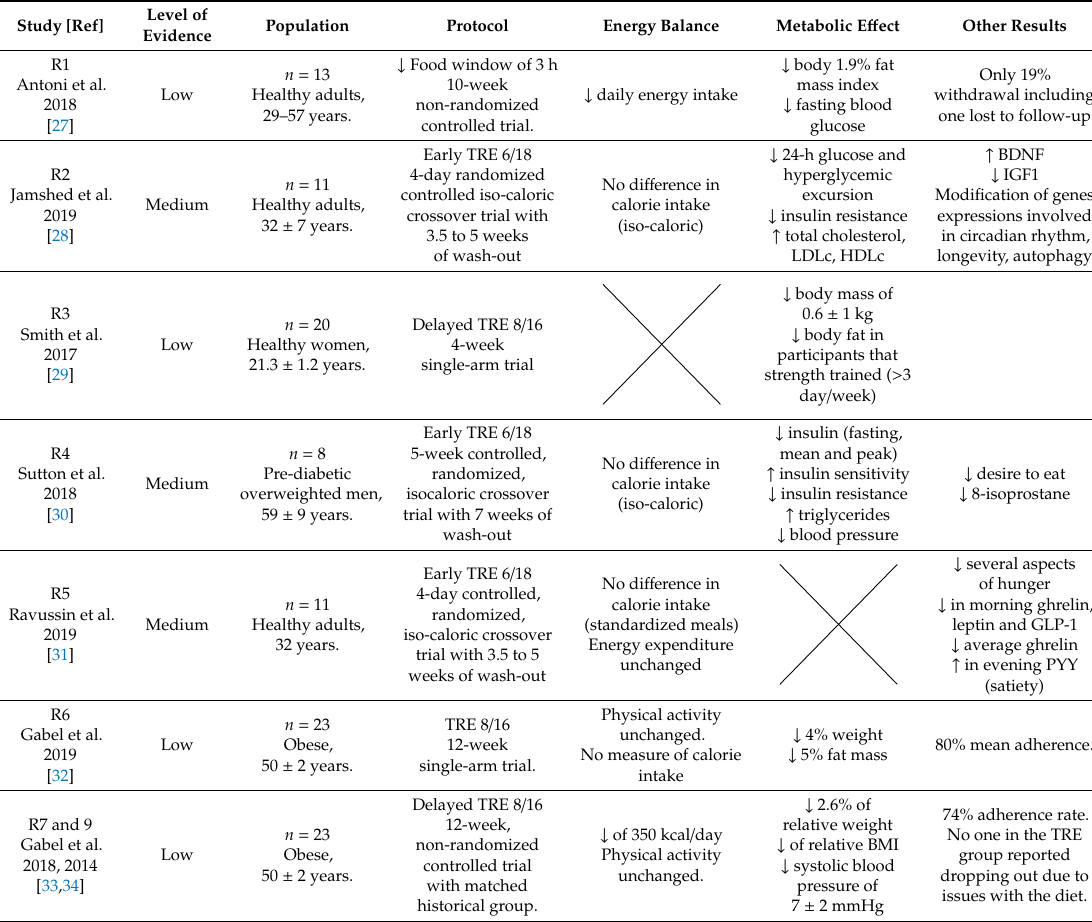
Table 1. Synthesis of results.